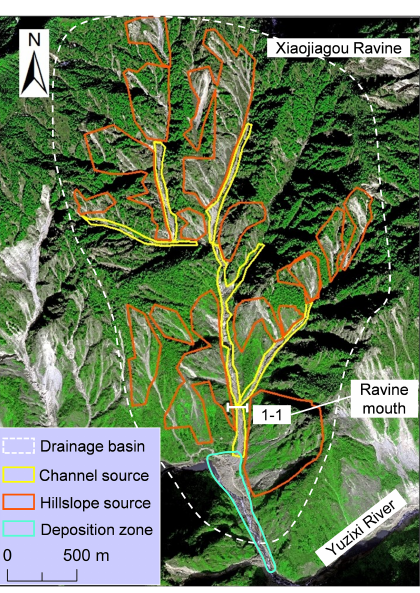
Figure 4. A satellite image of the study area taken shortly after the Xiaojiagou debris flow on 14 August 2010.